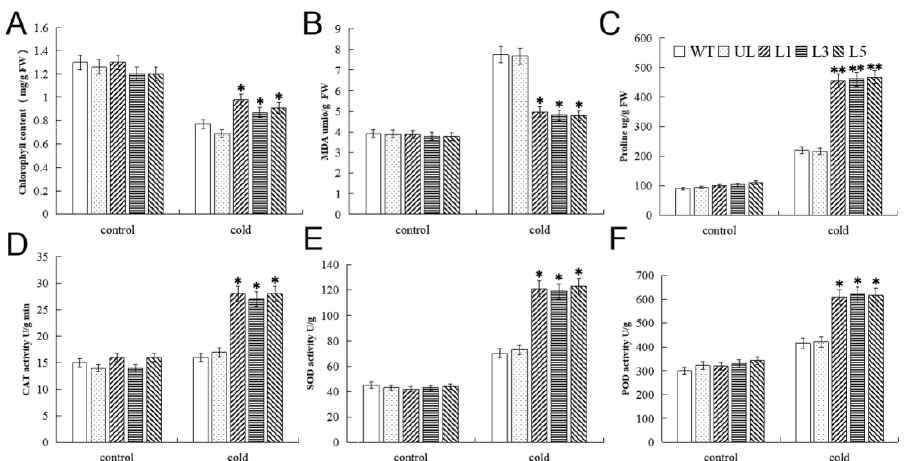
Figure 9. Physiological indicators in transgenic A. thaliana lines overexpressing FvMYB82 under low-temperature treatment. ( A ) Proline content, ( B ) MDA content, ( C ) chlorophyll content, ( D ) CAT activity, ( E ) SOD activity, and ( F ) POD activity in the WT, UL, and FvMYB82 -overexpressing lines (L1, L3, and L5) under the non-stress environment (22 °C) or cold treatment (4 °C for 12 h). Asterisks above each error bar indicate obviously significant differences between transgenic lines (L1, L3, and L5), UL and the WT (* p ≤ 0.05, ** p ≤ 0.01). The levels of indicators in the WT were used as the control.